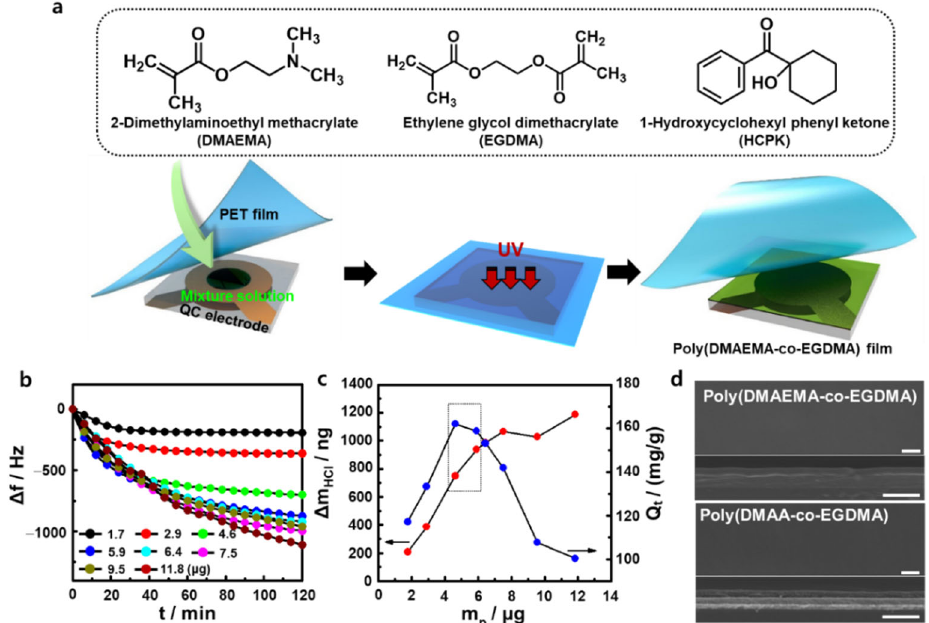
Figure 1. ( a ) Fabrication process of poly(2-dimethylaminoethyl methacrylate-co-ethylene glycol dimethacrylate), poly(DMAEMA-co-EGDMA), film via photopolymerization. ( b ) Resonant frequency change ( ∆ f) as a function of adsorption time of poly(DMAEMA-co-EGDMA) films, ranging from 1.7 to 11.8 µ g, in 70-ppm HCl gas flow, at 22 ◦ C and 10% RH. ( c ) Mass change ( ∆ m) and binding capacity (Qt) as a function of film mass of poly(DMAEMA-co-EGDMA) film in 70-ppm HCl gas flow, at 22 ◦ C and 10% RH. ( d ) SEM images for poly(DMAEMA-co-EGDMA) and poly( N , N -dimethylacrylamide-co-EGDMA), poly(DMAA-co-EGDMA), films (above: top view; bottom: cross-sectional view). All scale bars are 1 μ m.